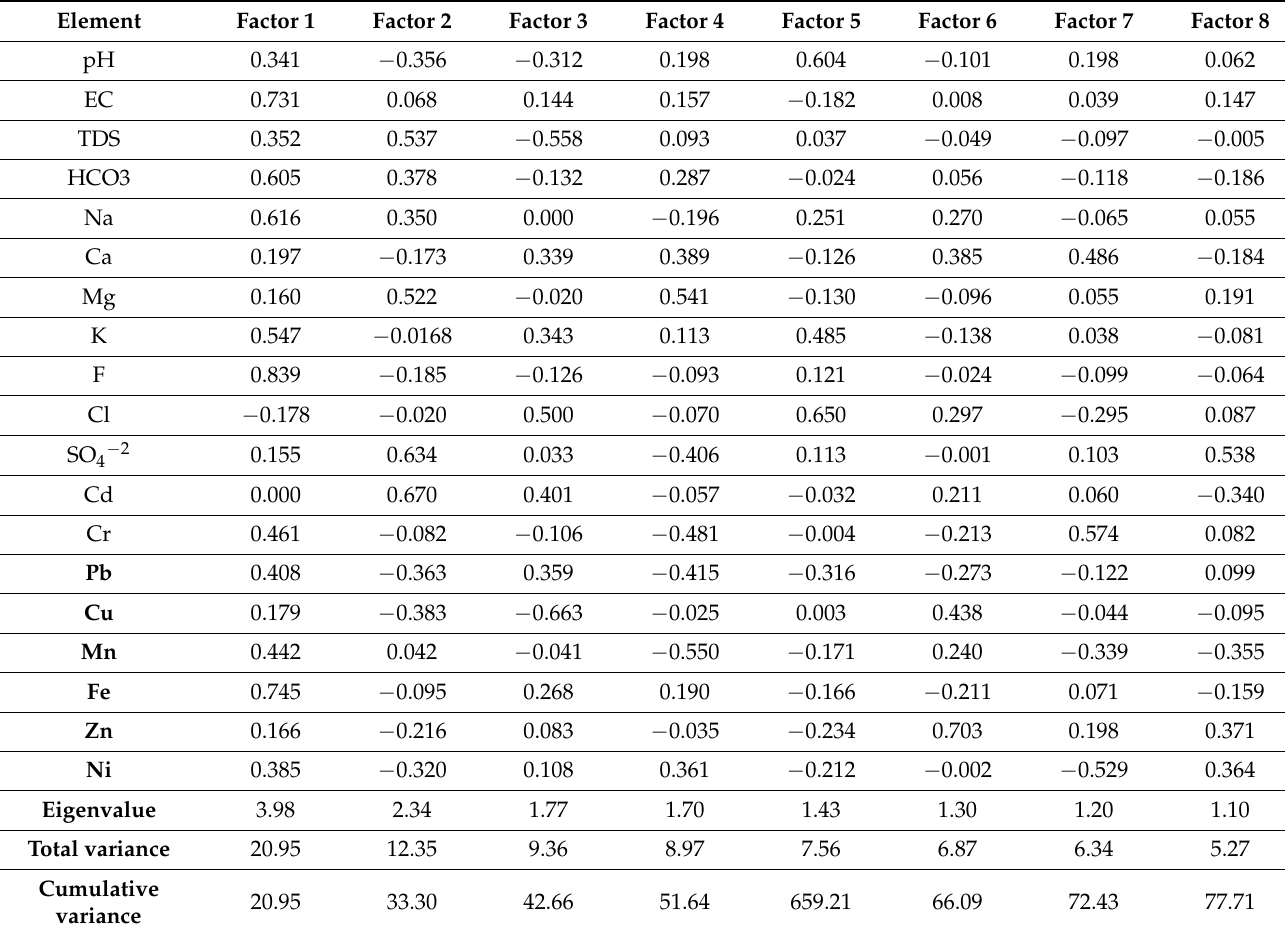
Table 5. Principal component analysis of physicochemical parameters and heavy metals in ground- water in coastal area of Baluchistan,